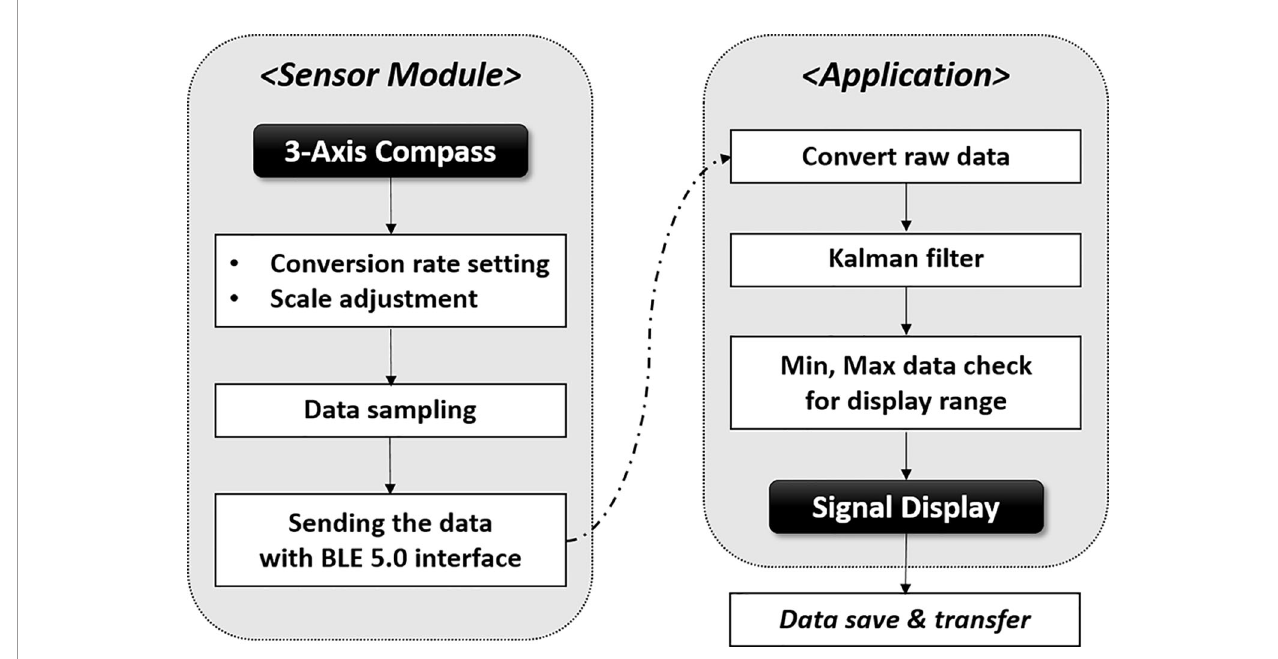
FIGURE 2 | System fl owchart for displaying respiratory signal in the mobile